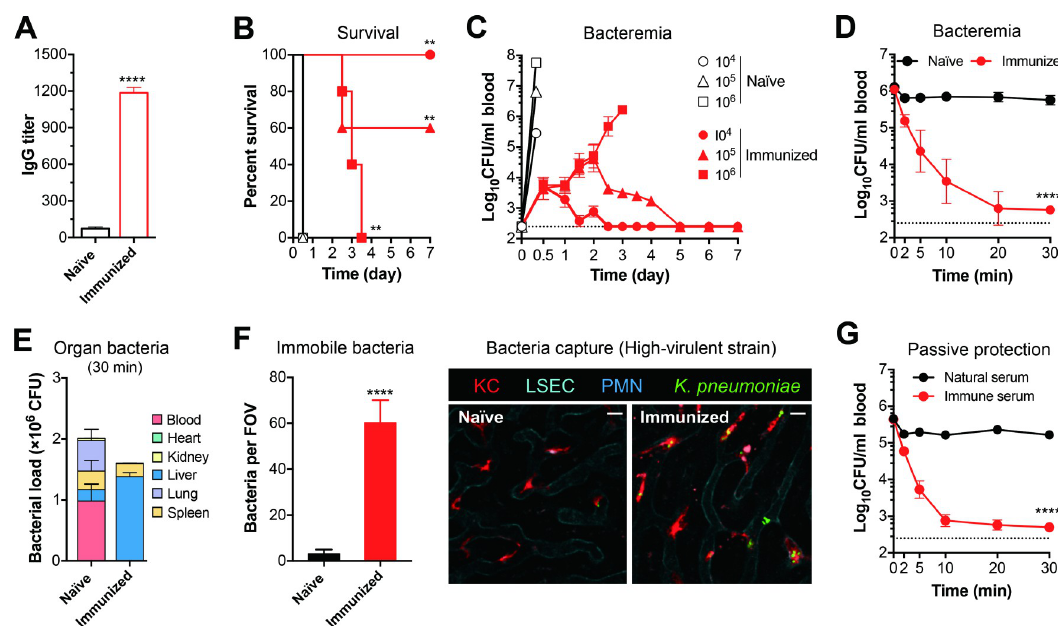
Fig 8. Vaccination to boost capture of HV K . pneumoniae by KCs. A. Anti- K . pneumoniae IgG titer in vaccinated mice. CD1 mice were immunized twice, one week apart, by subcutaneous injection of 10 8 formaldehyde inactivated ATCC43816). Sera were collected from untreated (na ï ve) or immunized mice by retro-orbital bleeding two weeks after the second immunization and antibody titers against ATCC43816 were evaluated by ELISA. n = 3. B, C. Immunoprotection against HV K . pneumoniae infection. CD1 mice were immunized as in (A), and i.p. infected with different lethal doses (10 4 , 10 5 , or 10 6 CFU) of ATCC43816 to determine survival (B) and bacteremia levels (C) . n = 5. D, E. Impact of immunization on the early clearance of HV K . pneumoniae by the liver. Bacteremia kinetics ( D ) and bacterial distribution ( E ) in the blood and five major organs of na ï ve or immunized mice at 30 min post i.v. infection with 10 6 CFU of ATCC43816 are presented. n = 3. F. Vaccine-activated pathogen capture by Kupffer cells. Pathogen capture by KCs in the liver sinusoids of na ï ve and vaccinated mice was assessed by IVM post i.v. infection with 5 × 10 7 CFU of ATCC43816 as in Fig 5F. Six random fields of IVM images were used to quantify KC-associated bacteria per field of view (FOV) (left panel). Representative IVM images (right panel) are shown at the right panel. The process of bacterial capture is demonstrated in supplemental S4 Movie. Scale bar, 10 μ m. n = 2. G. Immune serum-mediated clearance of HV K . pneumoniae . Na ï ve CD1 mice were i.v. infected with 10 6 CFU of ATCC43816 pre-incubated with 25% natural or immune serum for 10 minutes at room temperature to determine bacteremia kinetics in the first 30 min. n = 5. Dash line denotes the detection limit. All data are presented as mean ± SD. Unpaired t test (A and F), log-rank test (B) and two-way ANOVA with Tukey’s multiple comparisons test (D and G) were performed. �� , P < 0.01; ���� , P < 0.0001.